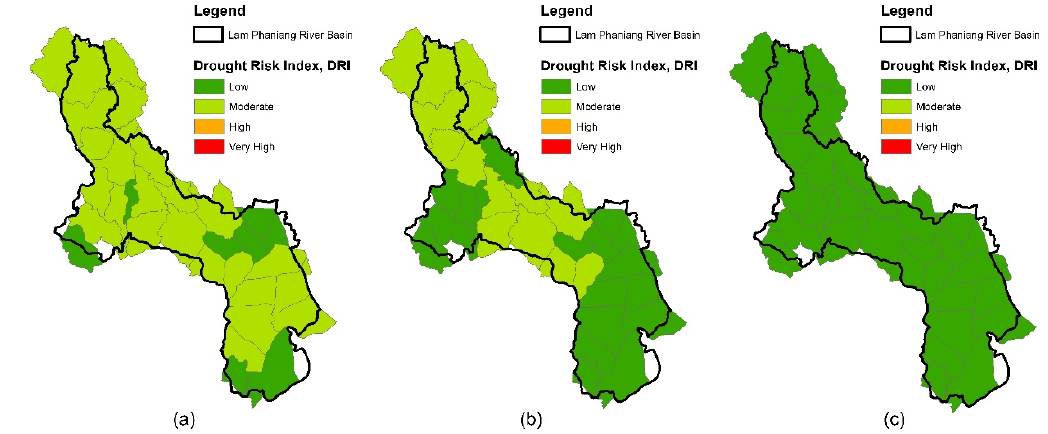
Figure 7. Spatial drought risk maps of the Lam Phaniang River Basin during 2000–2017 at ( a ) 3-, ( b ) 12-, and ( c ) 24-month time scales.